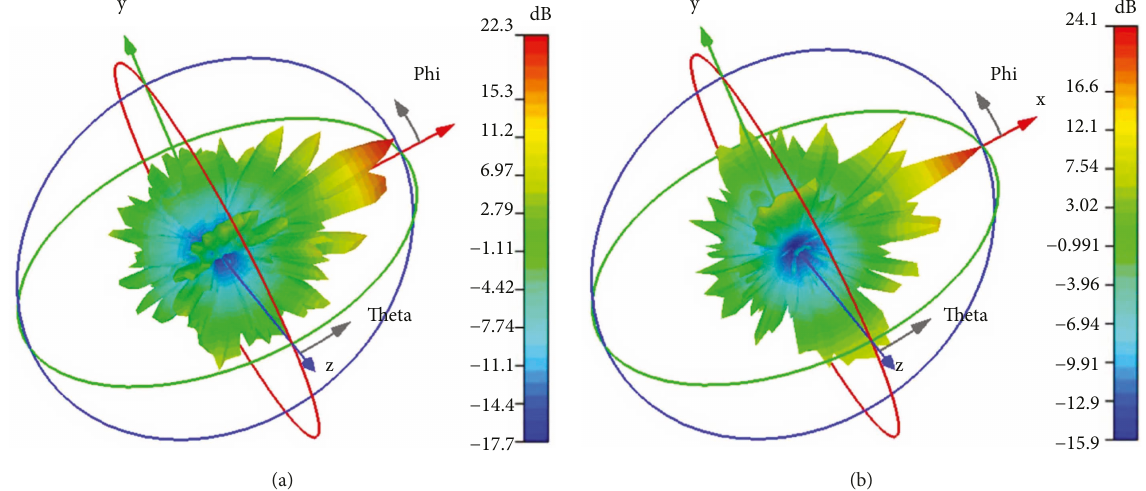
Figure 13: 3D radiation pattern of the proposed 4 × 4 mmW array unit cell (a) with a 22.3dBi gain at 28 GHz and (b) with a 24.1dBi gain at 38GHz.